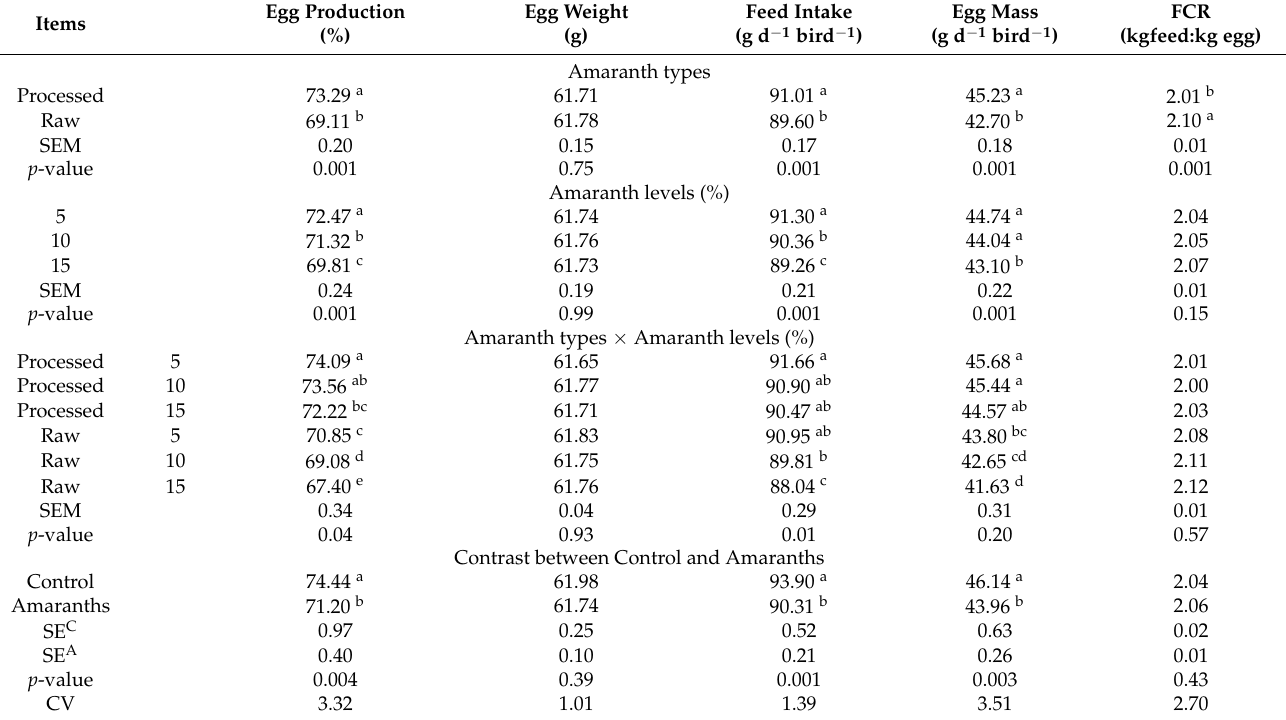
Table 3. Effect of trials diets on the performance on laying